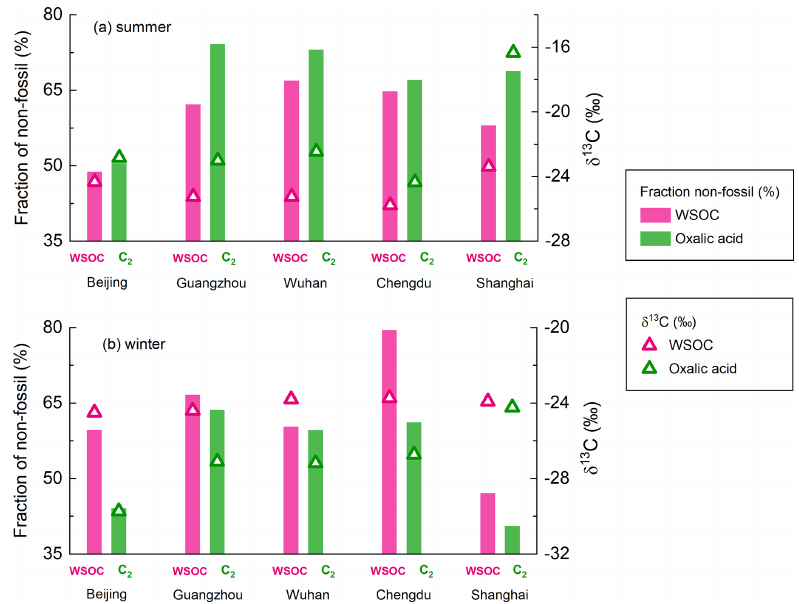
Figure 6. Proportions of non-fossil sources (determined from the 14 C values) and δ 13 C values for water-soluble organic carbon (WSOC) and oxalic acid (C 2 ) in Beijing, Guangzhou, Wuhan, Chengdu, and Shanghai in (a) summer and (b) winter.